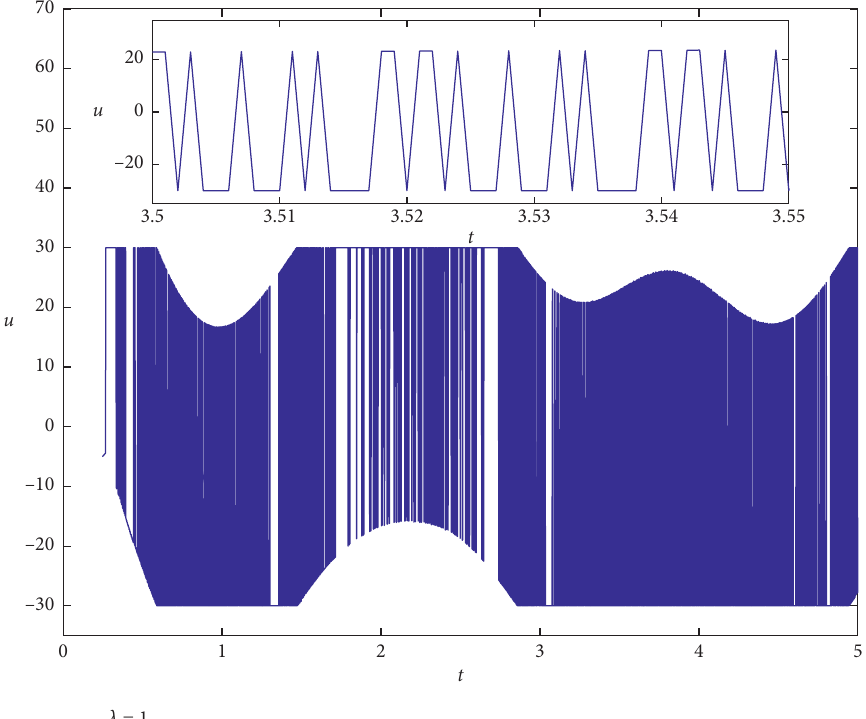
Figure 6: The time response of input signal u with λ �